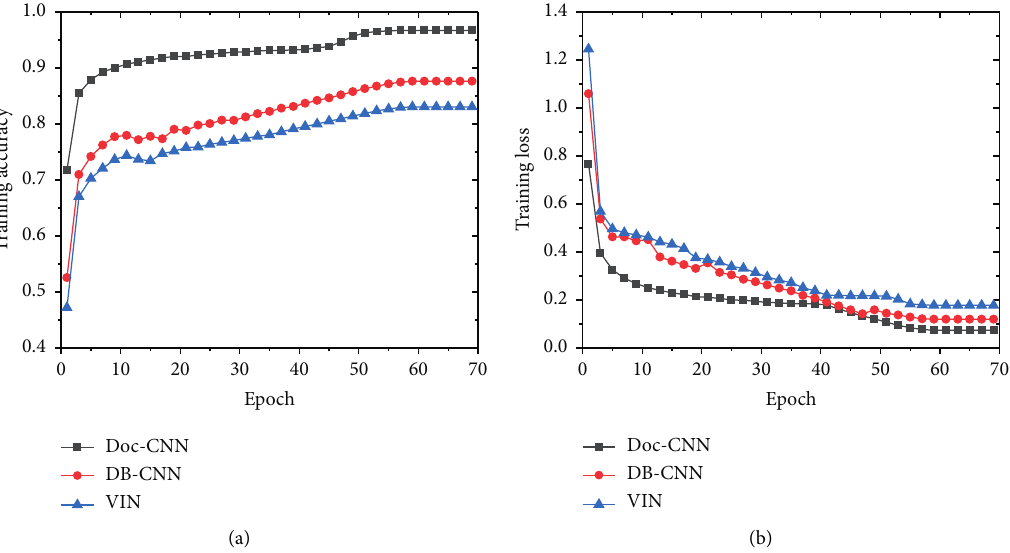
Figure 7: Training performance of all architectures on the grid dataset. (a) Training accuracy of the grid dataset. (b) Training loss of the grid